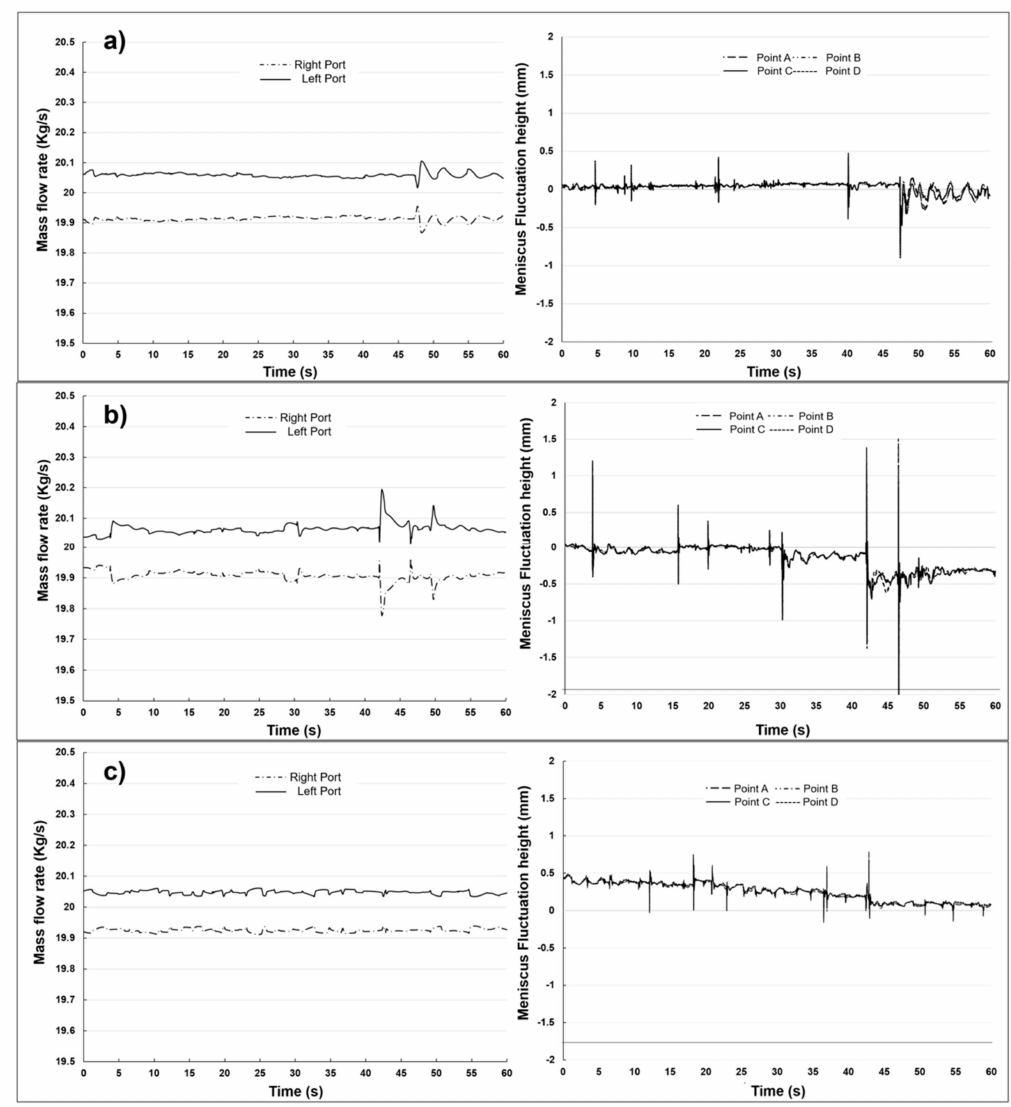
Figure 10. Mass flow rate in the SEN ports and meniscus fluctuation height during 60 seconds at unsteady-state conditions, H-EMBr, ( a ) 0.3, ( b ) 0.4 and ( c ) 0.5